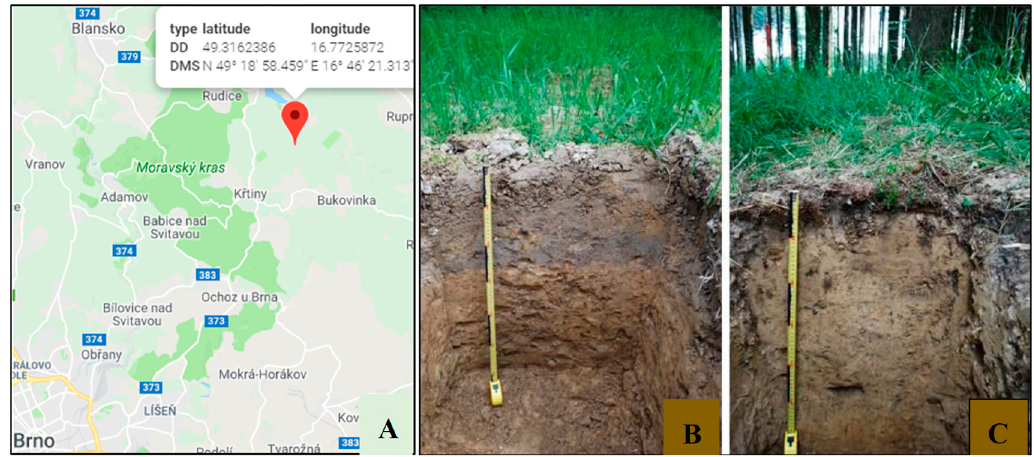
Figure 1. ( A ) Research site map, ( B ) Agriculture land, ( C ) Forest Figure 1 . ( A ) Research site map, ( B ) Agriculture land, ( C ) Forest region.